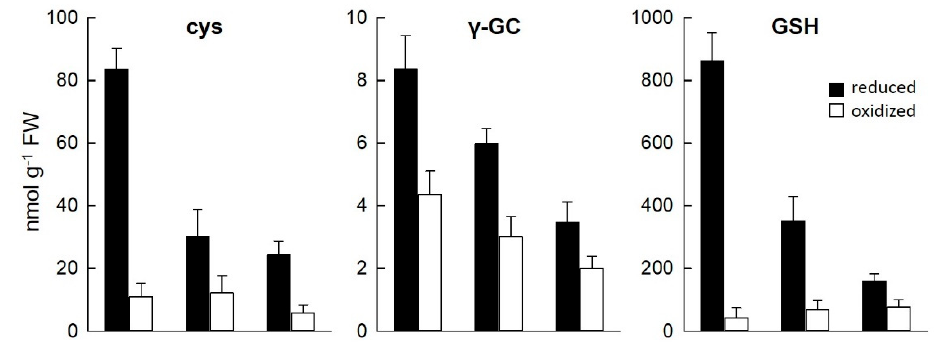
Figure 7. Oxidized and reduced content of Cys, γ -GC and GSH in florets, leaf blades and stems of Brassica rapa L. subsp. Sylvestris var. esculenta.